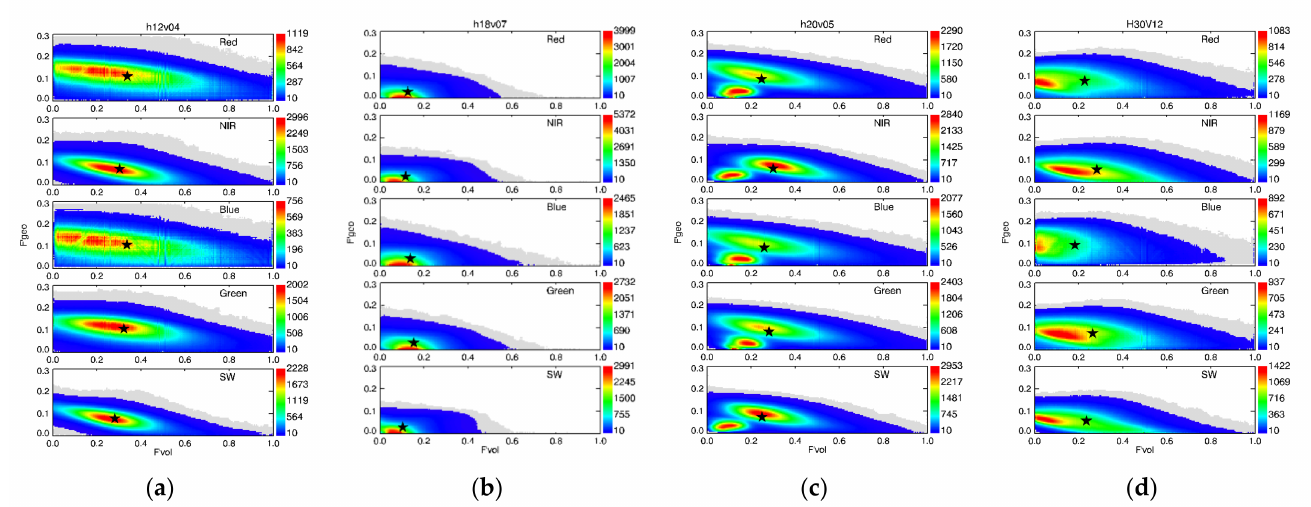
Figure 4. The scatter diagrams of F (cid:48) vol and F (cid:48) geo in MODIS tile h12v04 ( a ), h18v07 ( b ), h20v05, ( c ) and h30v12 ( d ) on DOY 170, 2010 at different spectra (b1–4) and broadband (b10) values. The pentacle represents the location of F . Different colors represent the number of pixels in a statistical